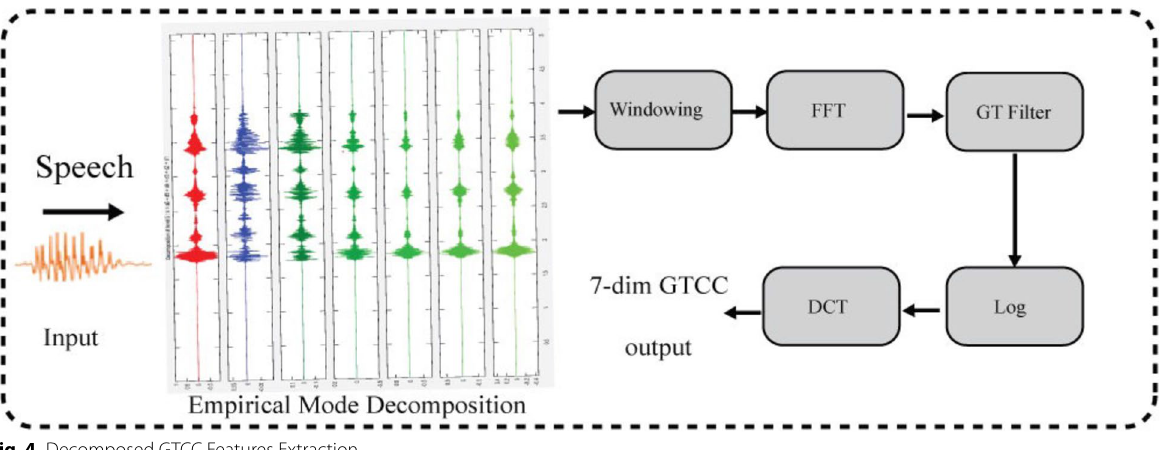
Fig. 4 Decomposed GTCC Features Extraction